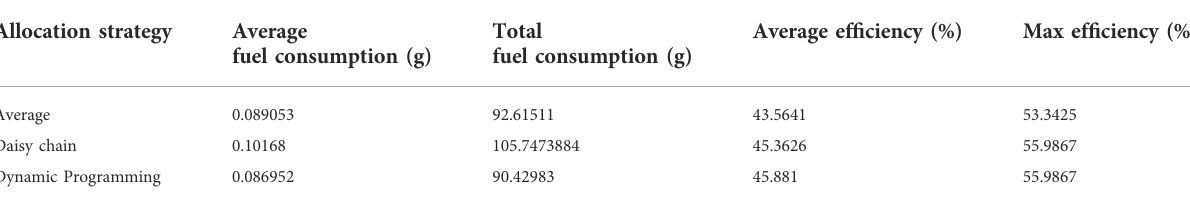
TABLE 3 Performance of different